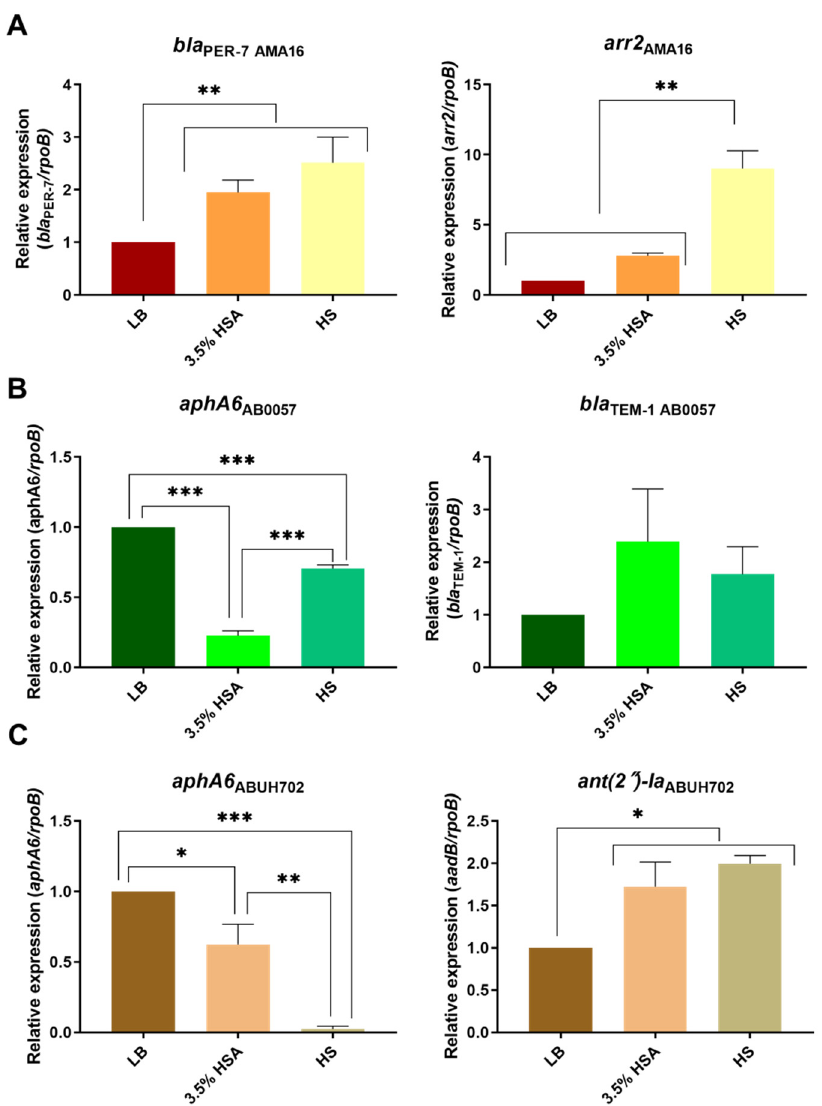
Figure 2. Effect of human serum albumin (HSA) and pooled normal human serum (HS) on the expression of antibiotic resistance genes of A. baumannii strains. qRT-PCR of AMA16: ( A ) AB0057 ( B ) and ABUH702 ( C ) strains genes associated with antibiotic resistance expressed in LB, LB supple- mented with 3.5% HSA, or in HS. Fold changes were calculated using double ∆∆ Ct analysis. At least three independent samples were used. LB was used as the reference condition. Statistical significance ( p < 0.05) was determined by ANOVA followed by Tukey’s multiple-comparison test, one asterisks: * p < 0.05; two asterisks: ** p < 0.01; and three asterisks: *** p < 0.001.